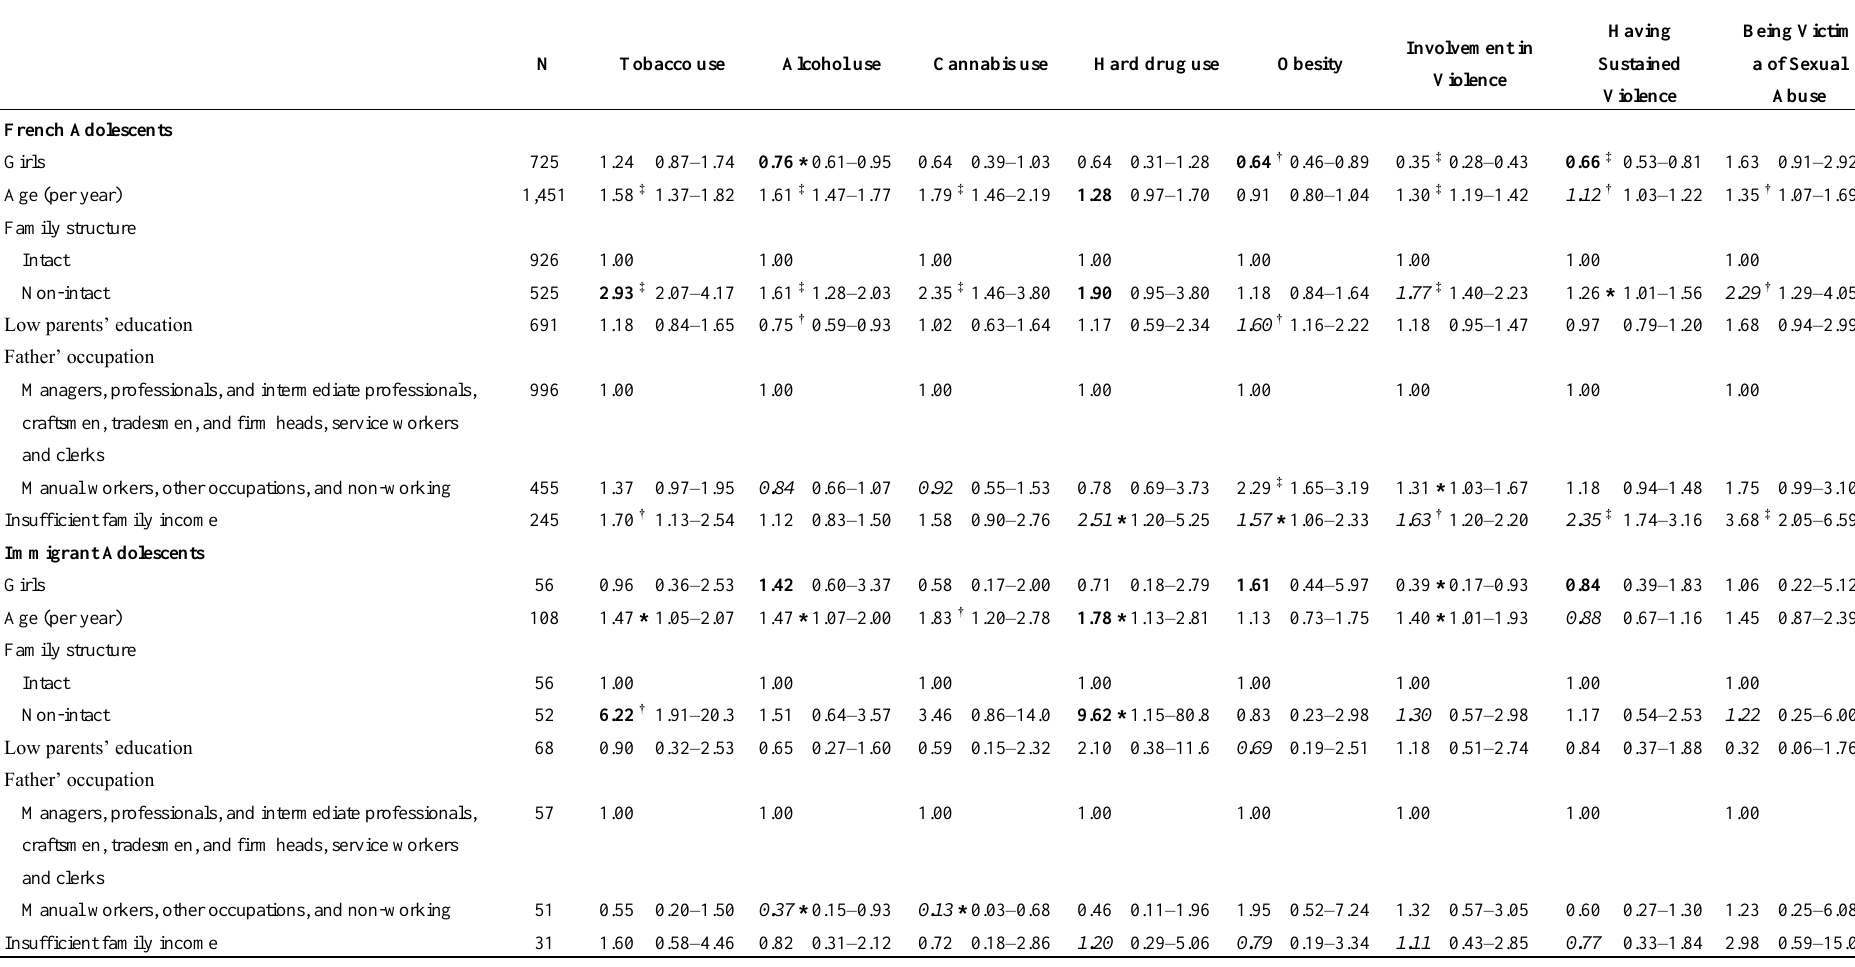
Table 5 . Associations between socioeconomic factors and unhealthy behaviors and violence (N = 1,559): gender-age-adjusted odds ratio and 95% confidence